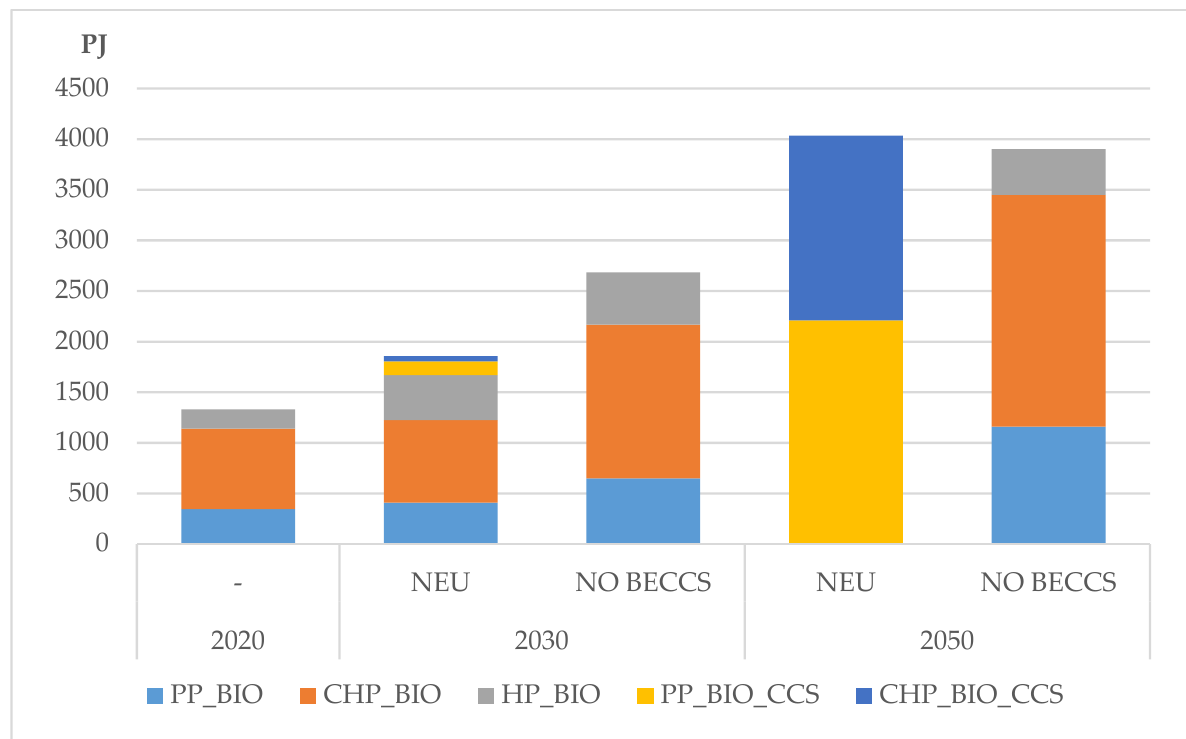
Figure 6. Use of biomass in the considered scenarios (in PJ). Source: own calculations based on MEESA model results.